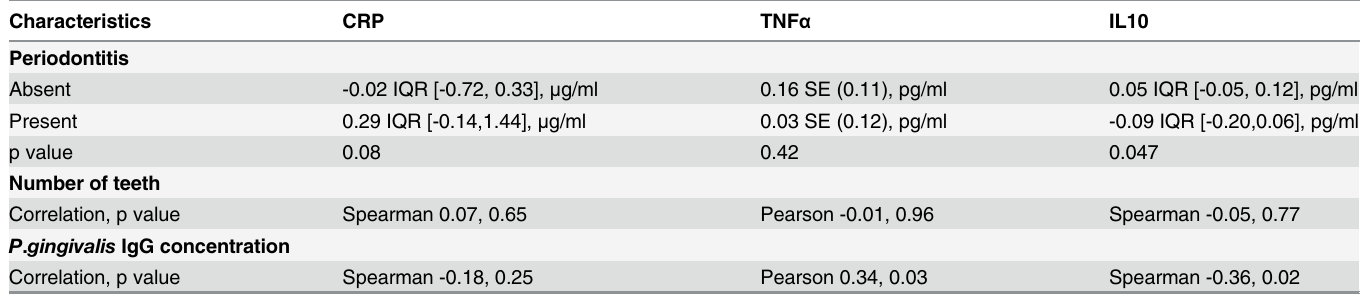
Table 4. Relationships between change in serum inflammatory markers from baseline and baseline dental health measures.